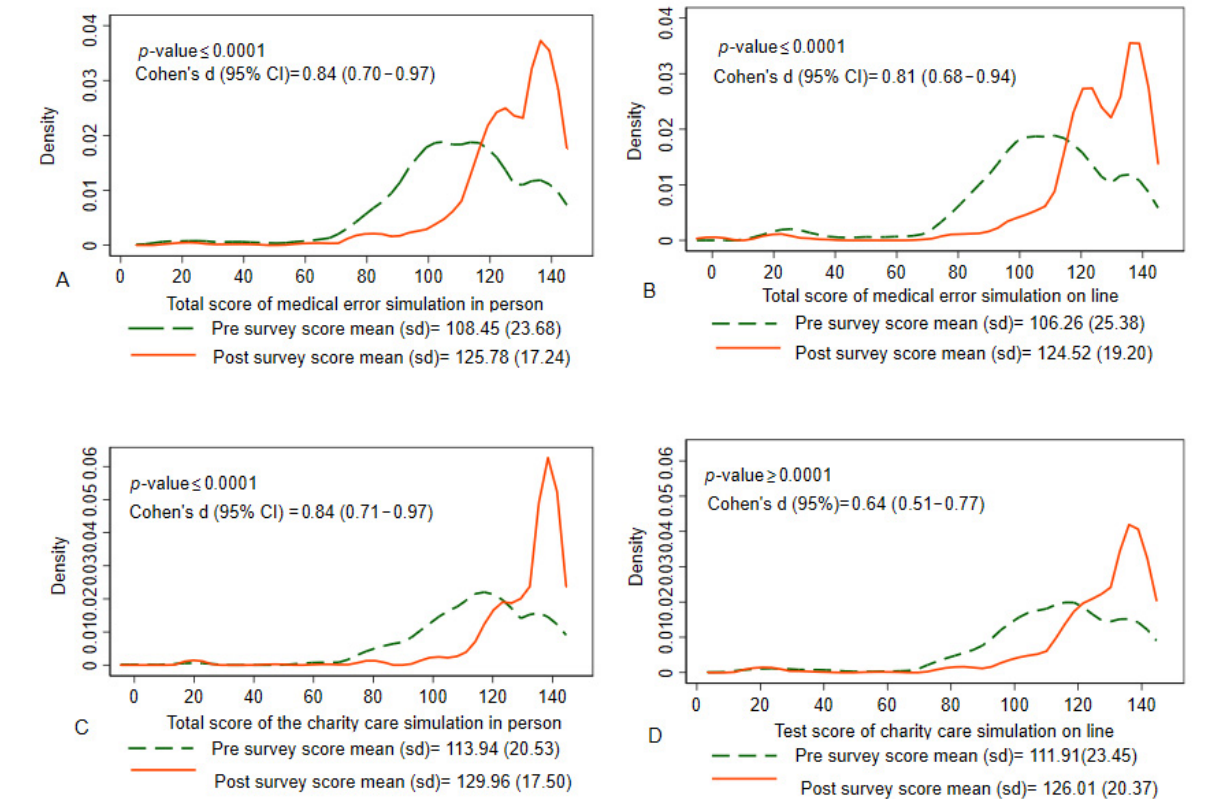
Figure 1. The density plots of the pre-survey and post-survey scores with mean (sd) and by the type of simulation, the Medical Error simulation in person and online (See ( A , B )) and the Charity Care simulation in person and online (See ( C , D )). Note: The figures show similar magnitude of effect for the medical error simulation in person and online, however when compared to the charity care simulation in person, the magnitude of effect decreases for the charity care simulation online.